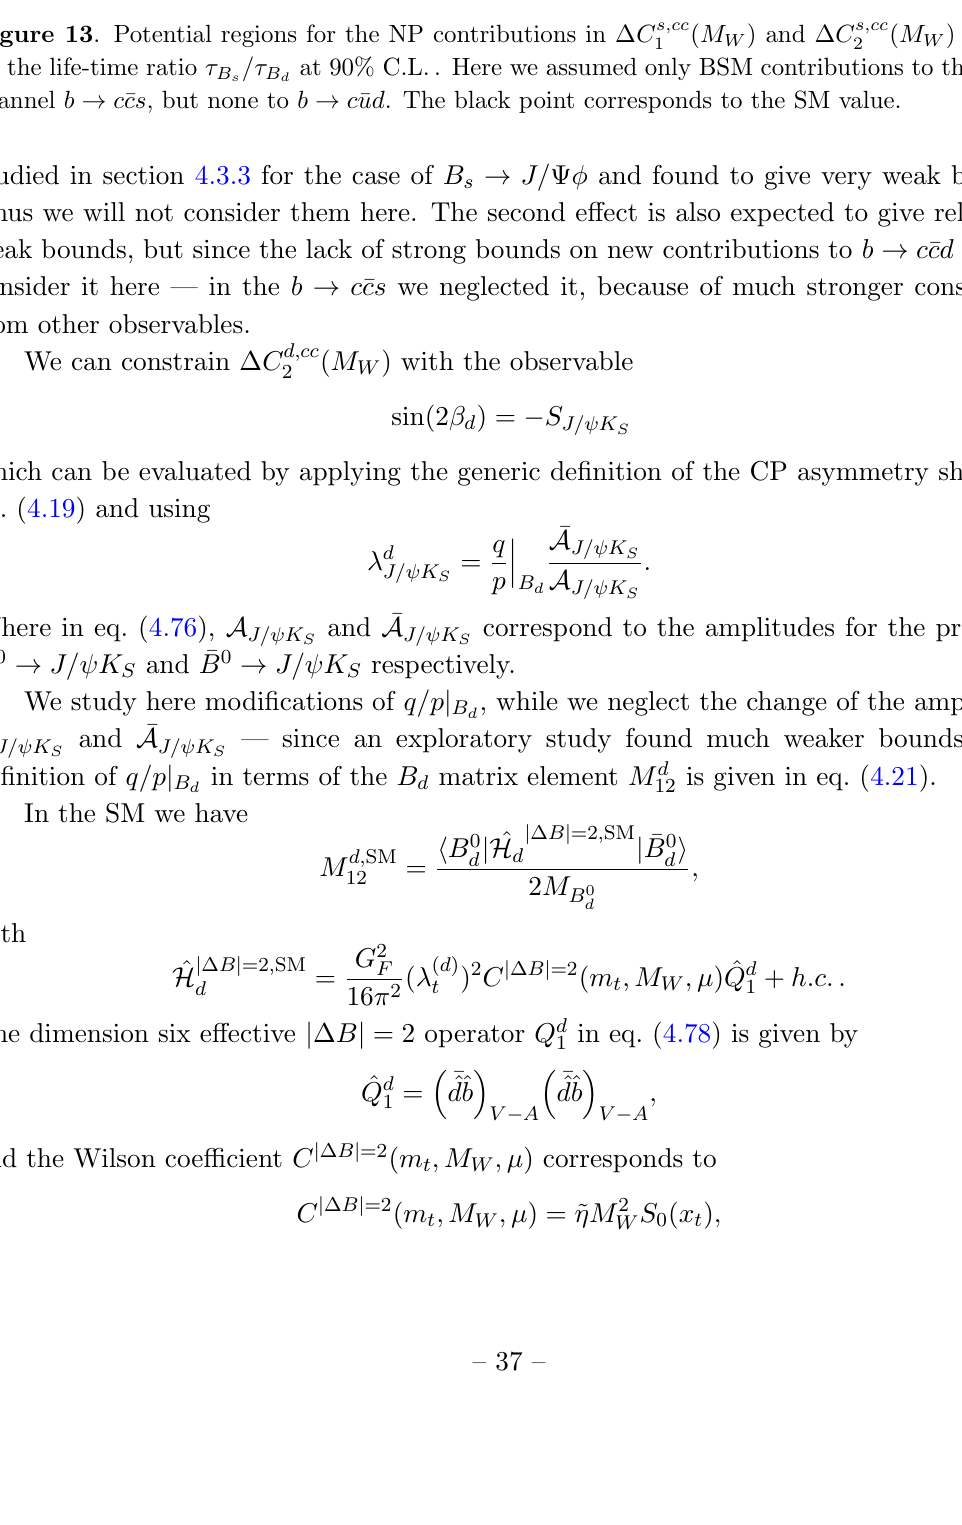
( M W ) and (cid:1) C s;cc ( M W ) allowed 1 2